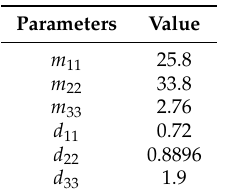
Table 1. Parameters of CyberShip II.